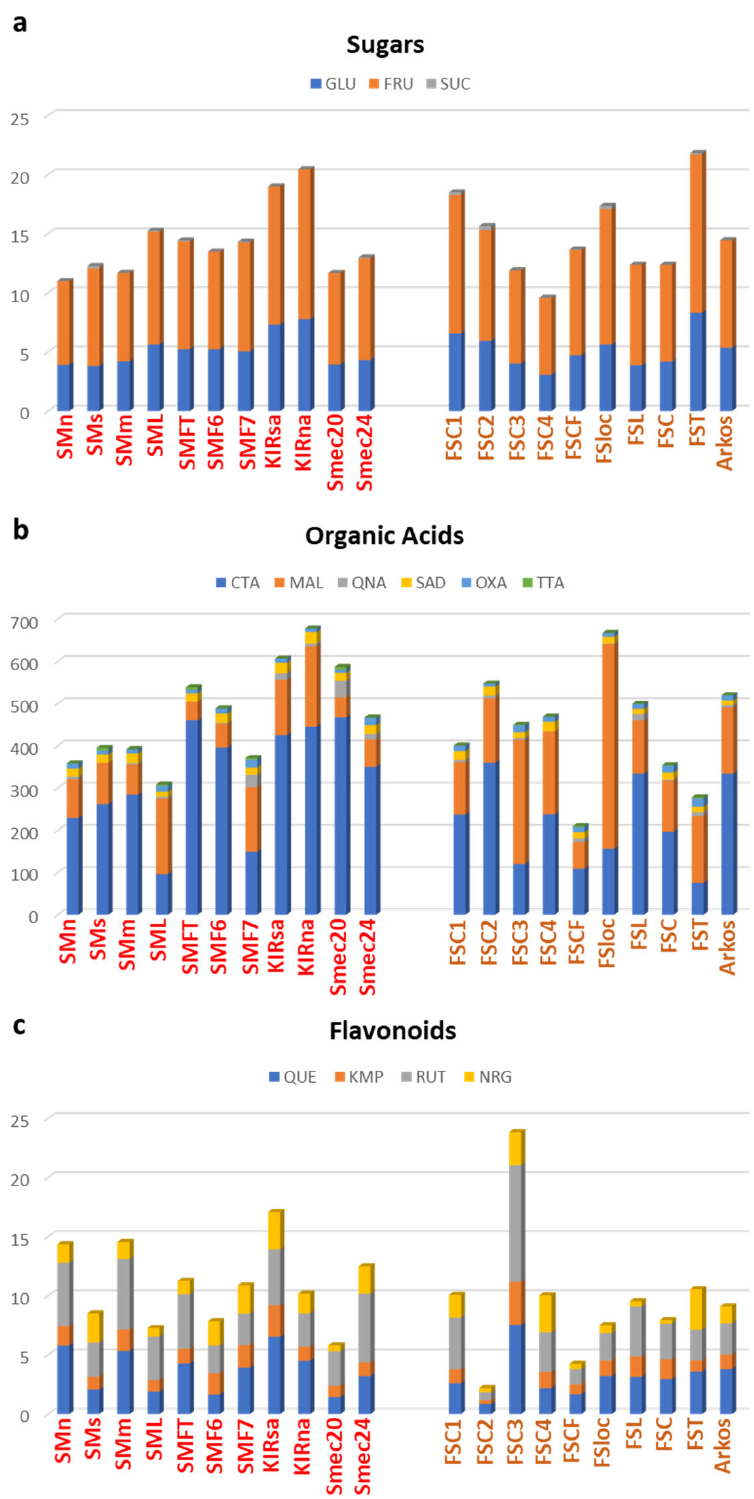
Figure 3. Stacked bars indicating the total amount of sugars ( a ), organic acids ( b ) and flavonoids ( c ) for eleven ‘San Marzano’ (red font) and ten ‘Re Fiascone’ (orange font) accessions. On the Y axis, ( a ) sugars (mg g − 1 FW); ( b ) organic acids (mg 100 g − 1 FW); ( c ) flavonoids (mg Q3G 100 g − 1 FW).